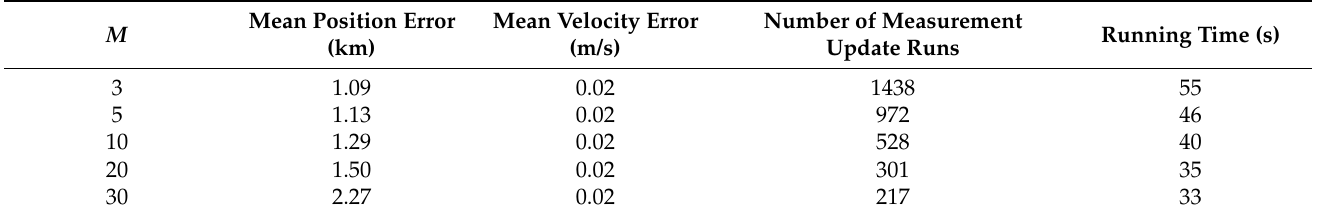
Table 6. Navigation results of the parameter-independent event-triggered mechanism only consider- ing innovation, with different M .